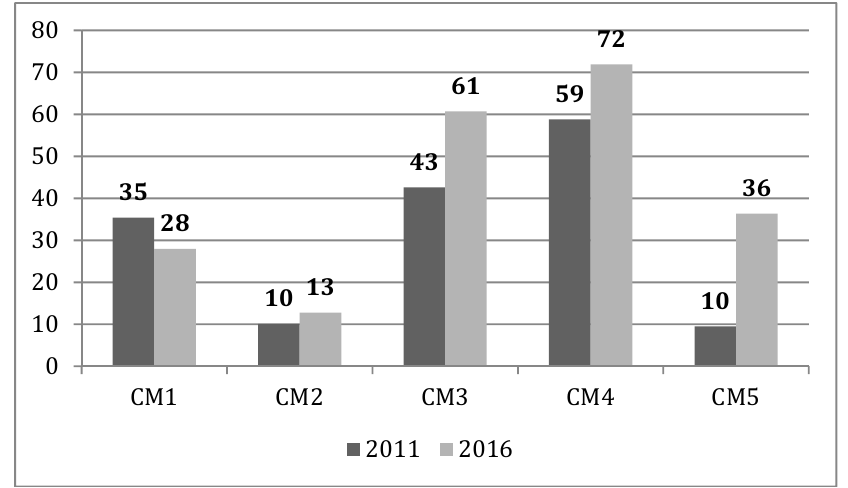
Figure 7. The results of the assessment of economic criteria in 2011 and 2016 in the examined hard coal mines. Source: own work.